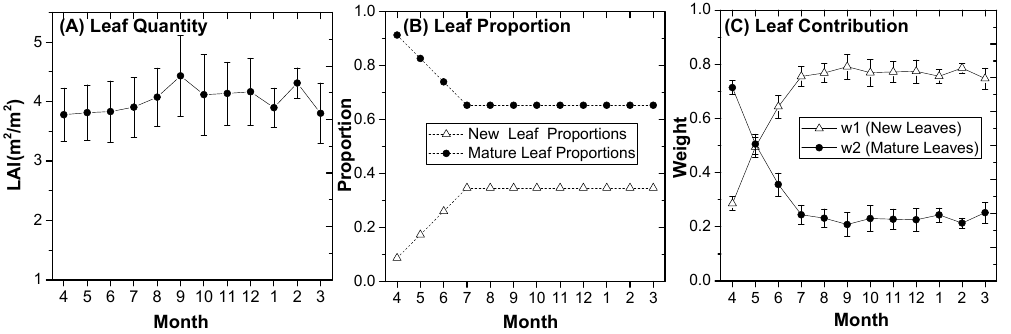
Figure 9. Seasonal variations in the leaf properties of the canopy, including ( A ) total leaf area: average LAI from stand age 22 to 33 (2005 to 2015); ( B ) leaf proportion: the percentage of new leaves and mature leaves in the canopy measured by Zhongkun et al. [50]; ( C ) weights for new leaves ( w1 ) and mature leaves ( w2 ) from stand age 22 to 33 (2005 to 2015).